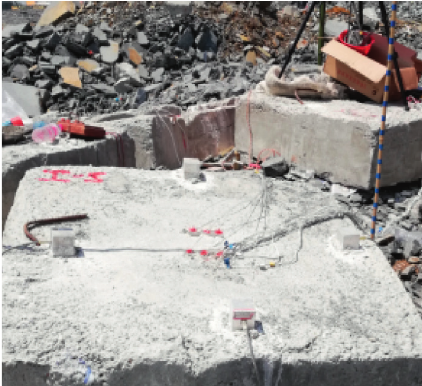
Figure 21: Actual layout of blasting vibration sensors.